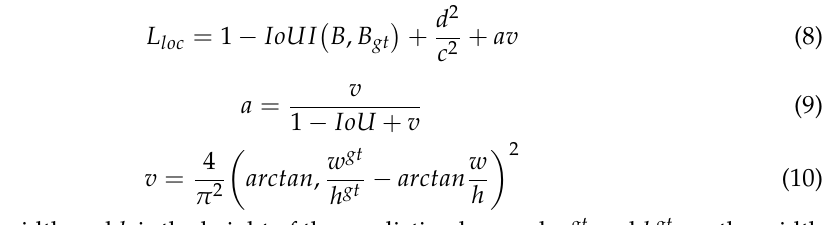
Figure 5. The SPPF module.